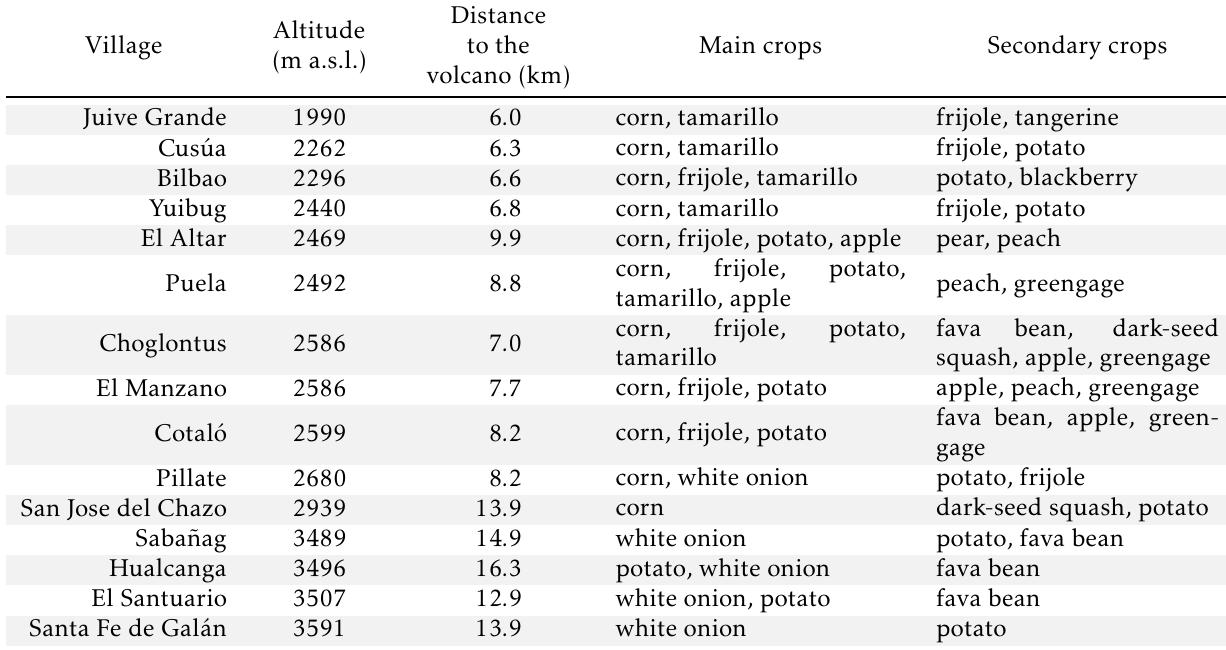
Table 1: Names, altitudes, and distances to the volcano of the 15 villages where the farmer interviews took place, and list of the main and secondary crops cultivated in these localities as in 2014. A map of the village locations is shown in Figure